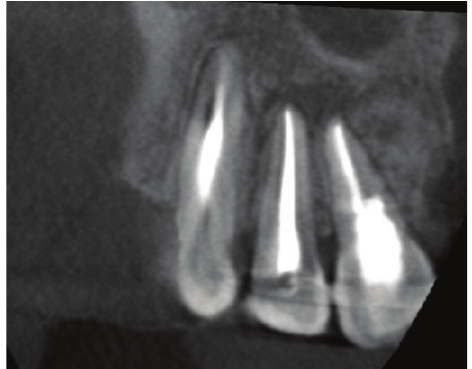
Figure 24: 1-year followup CBCT image in coronal plane.